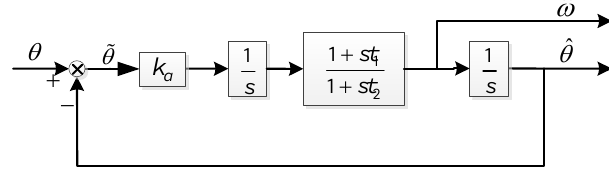
Figure 3. Simplified form of system response block diagram of AD2S1210.